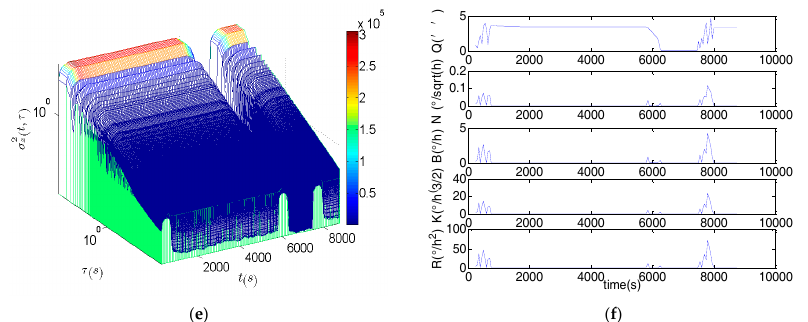
Figure 4. Dynamic Allan variance (DAVAR) and the noise term of the fixed-frequency vibration test. ( a ) The DAVAR of the FOG along X axis; ( b ) The coefficients of noise terms in the FOG along X axis; ( c ) The DAVAR of the FOG along Y axis; ( d ) The coefficients of noise terms in the FOG along Y axis; ( e ) The DAVAR of the FOG along Z axis; ( f ) The coefficients of noise terms in the FOG along Z axis.